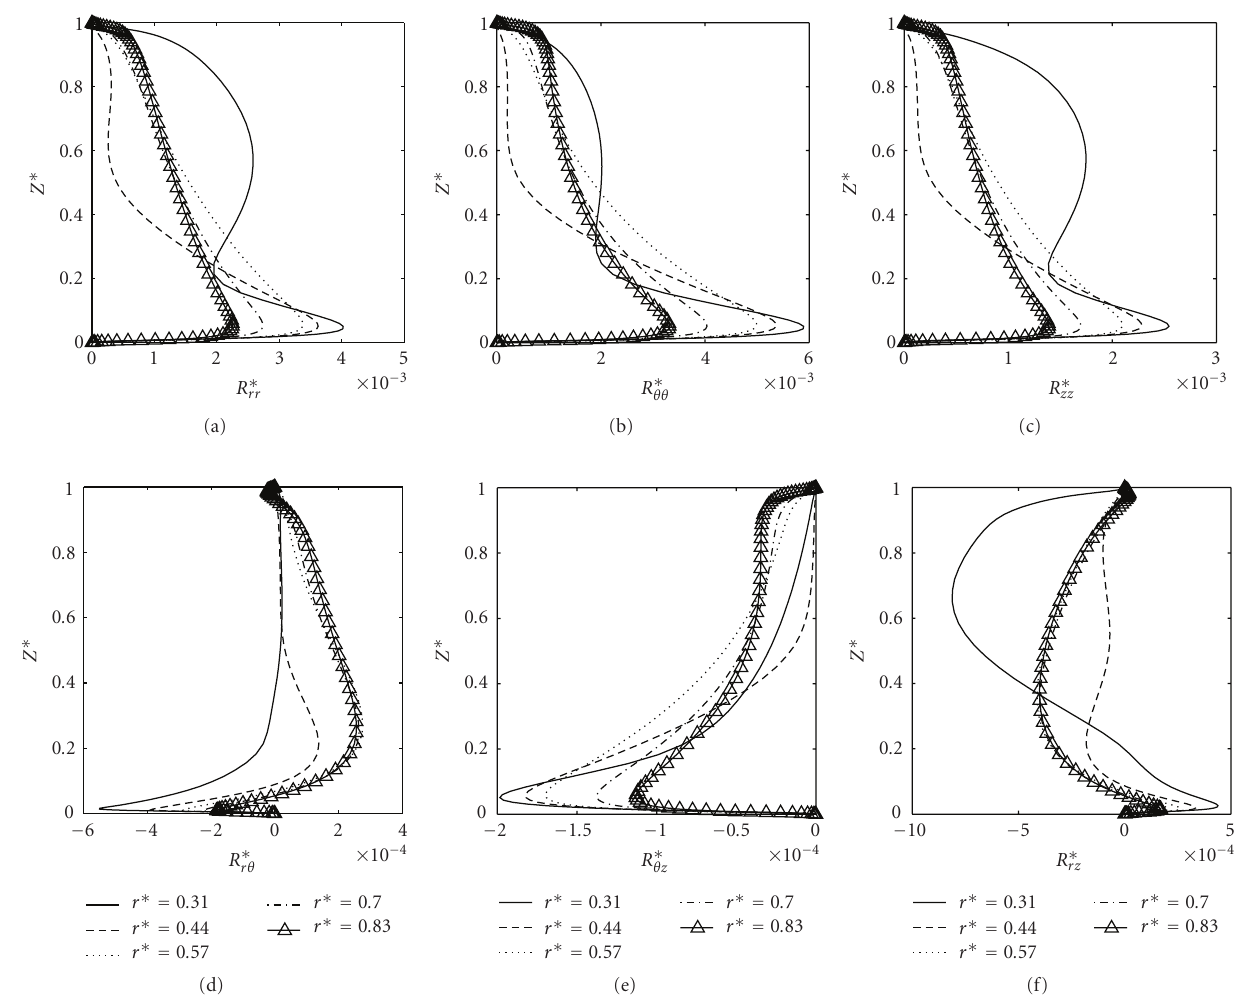
Figure 18: Axial profiles of the six Reynolds stress tensor components for Re = 10 6 , G = 0 . 02, and C w = − 2500 at di ff erent radial locations r ∗